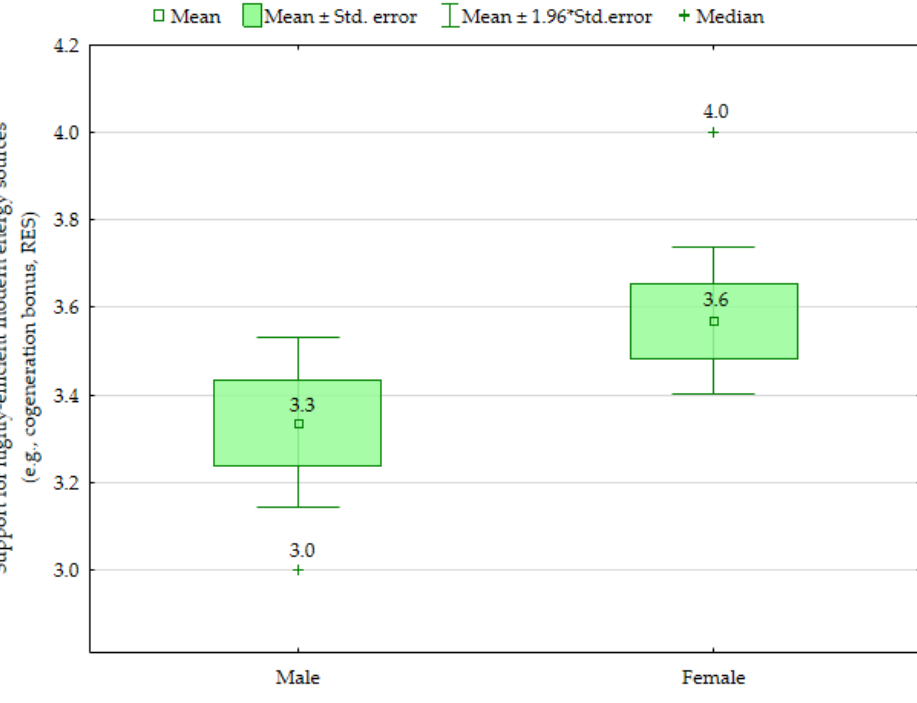
Figure 8. Gender and the assessment of support for the development of highly efficient, modern energy sources (e.g., cogeneration bonus, RES). Source: Own elaboration based on the conducted research, n = 444.